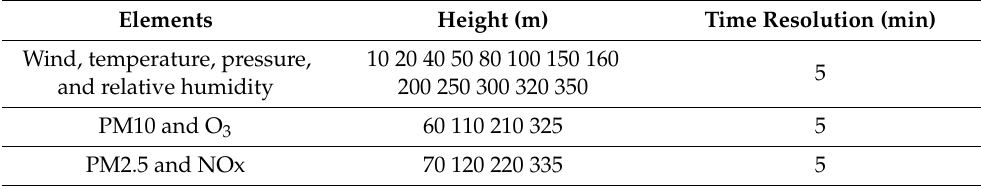
Table 1. Overview of meteorological and pollutant elements from the equipment on the tower.